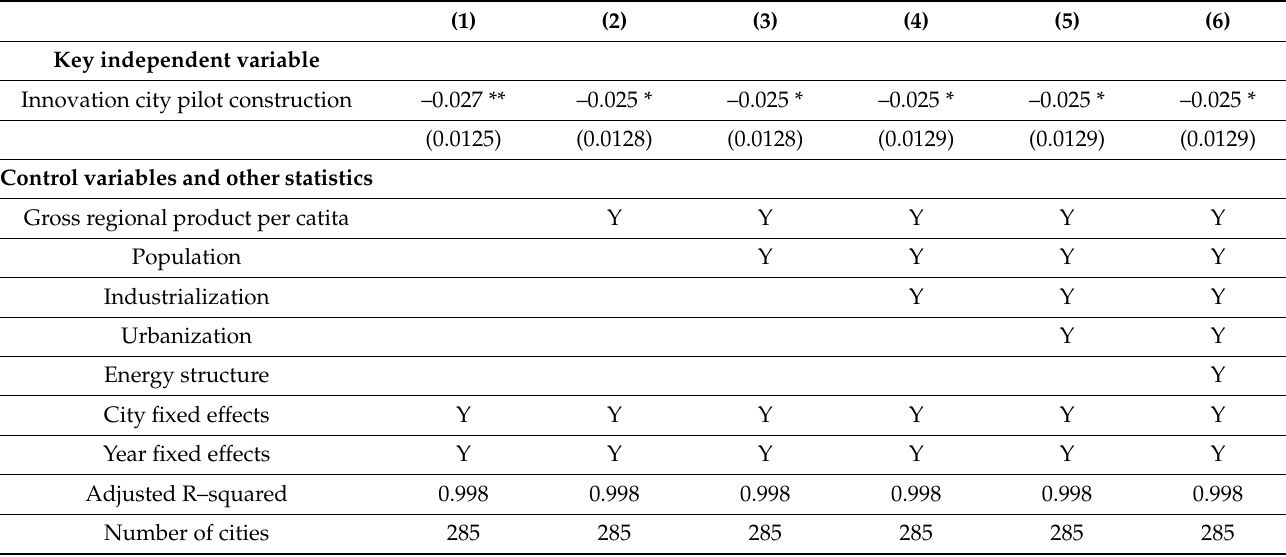
Table 3. Estimates in the impact on carbon emissions from inverse-probability-weighting difference- in-differences